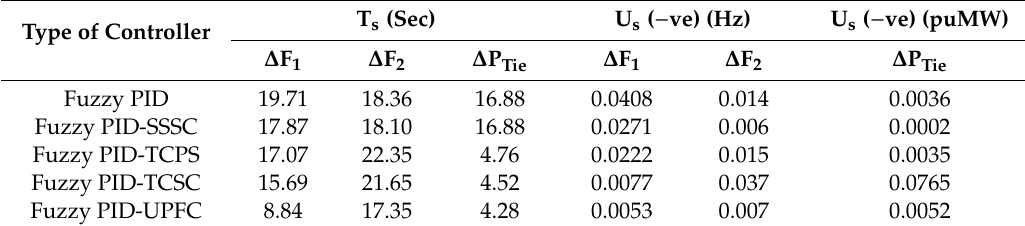
Table 2. Index values.